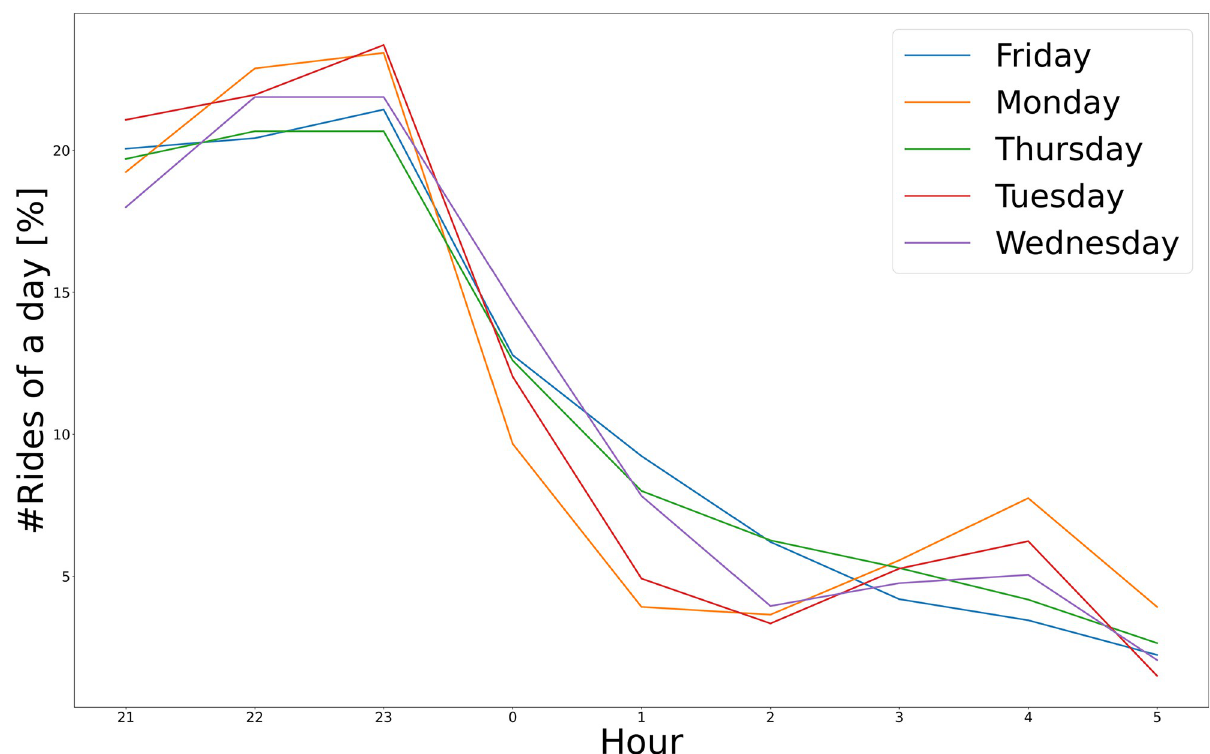
Fig 8. Time-series analysis of the clustered dataset. The characteristics of the rides are close to each other during the weekdays.